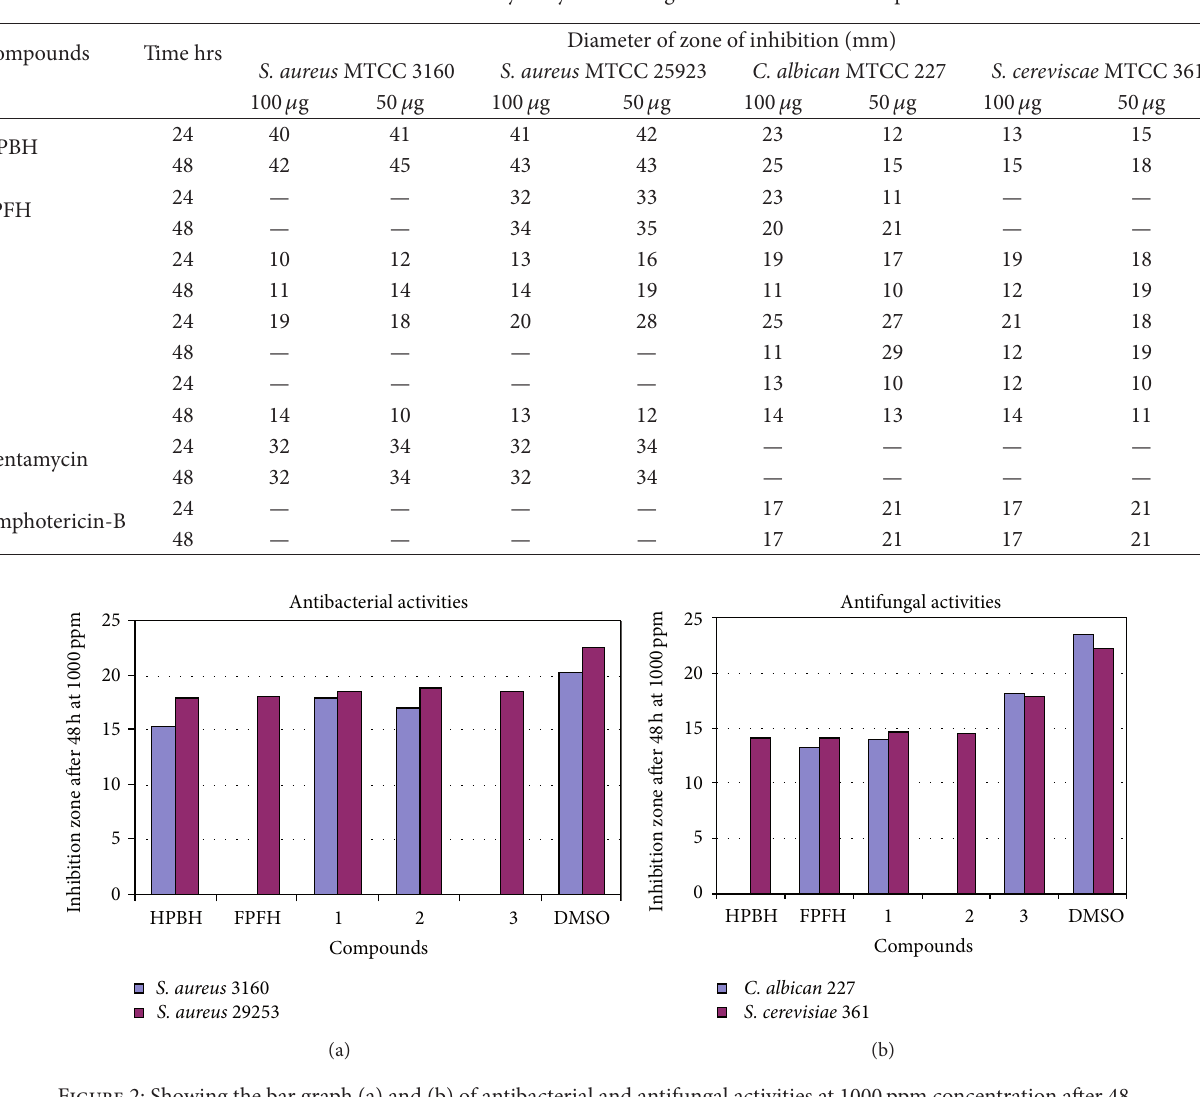
F 2: Showing the bar graph (a) and (b) of antibacterial and antifungal activities at 1000ppm concentration aer